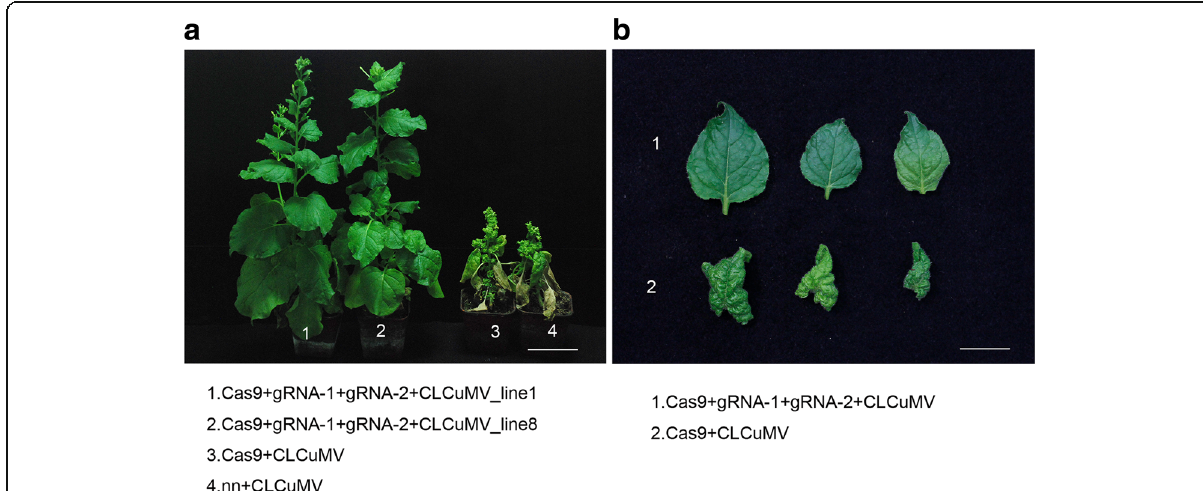
Fig. 4 Symptoms on N. benthamiana plants inoculated with the infectious CLCuMuV and CLCuMuB clones. a Representative images of control and transgenic plants 35days (dpi) with CLCuMuV and CLCuMuB. 1 to 4 represent Cas9+gRNA-1+gRNA-2 transgenic line1, Cas9+gRNA-1+gRNA-2 transgenic line8, Cas9 transgenic, and WT, respectively. Bar=8cm. b The phenotype of the third, fourth and fifth leaves at the top of transgenic plants 20 dpi with CLCuMuV and CLCuMuB. Group 1 and 2 represent Cas9+gRNA-1+gRNA-2 transgenic line1 and Cas9 transgenic, respectively.